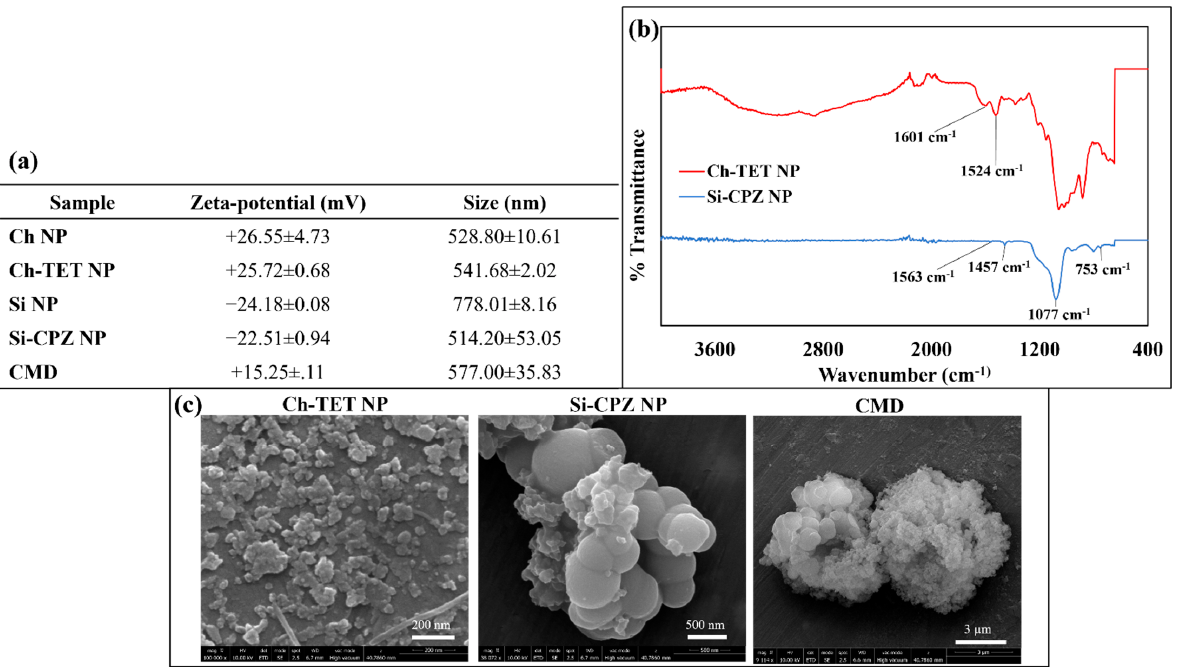
Figure 2. Characterization of particles. ( a ) Tabulated data showing zeta-potential, and the size of the particles measured using dynamic light scattering (DLS). ( b ) FTIR spectrum of Ch-TET NP and Si- CPZ NP. ( c ) Nanoparticles were platinum-coated and imaged using Scanning Electron Microscopy (SEM).